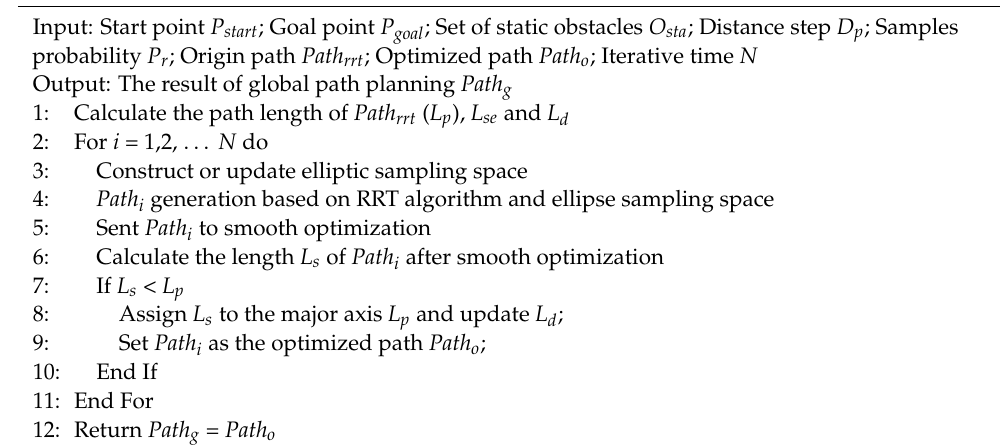
Algorithm 2 : Global path planning algorithm based on RRT